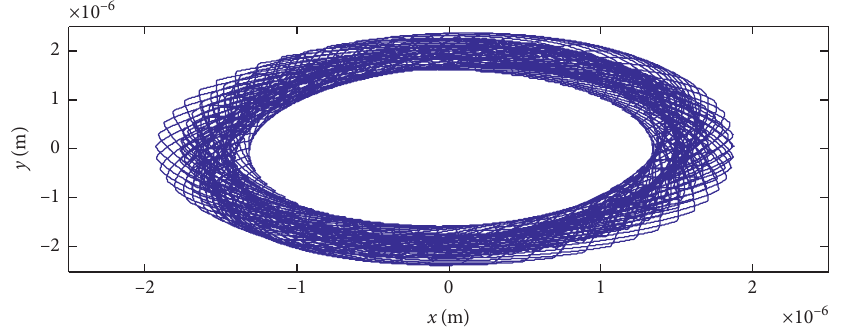
Figure 10: The center track of the sun